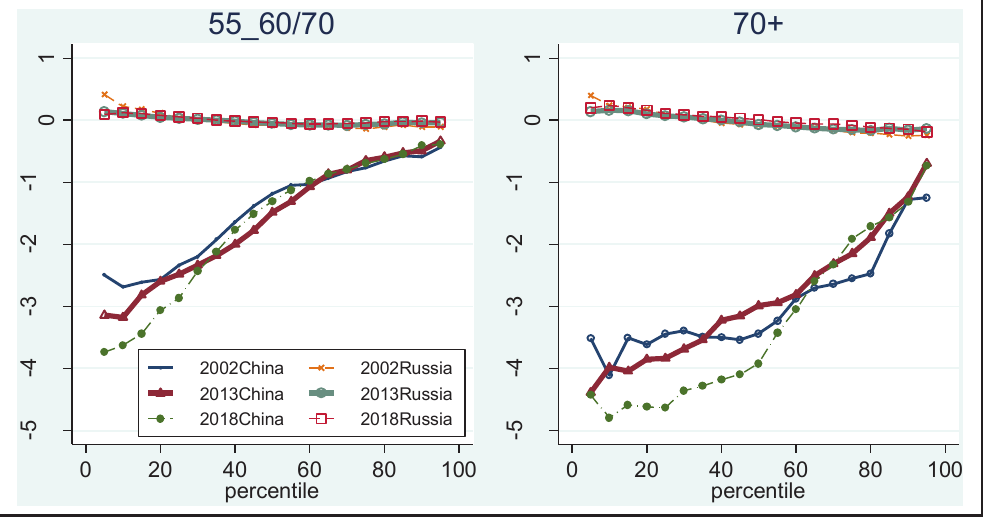
Quintile regression coefficients on age from earnings equations by